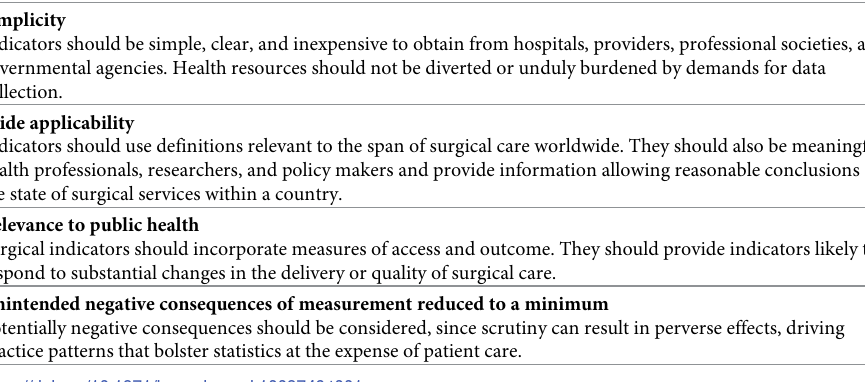
Table 1. Guiding principles for global surgery indicators